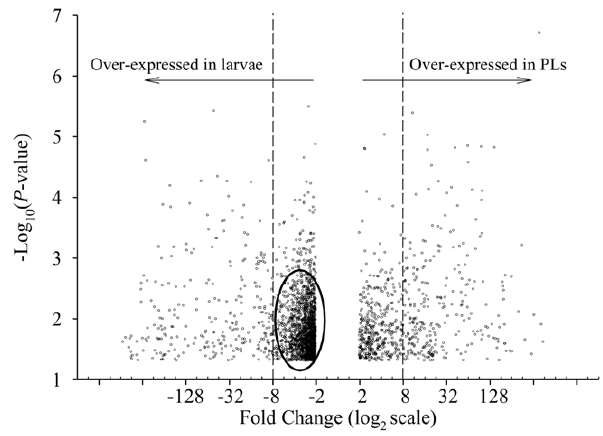
Figure 2. Volcano plot of transcript expression differences between larval and post-larval prawns. The magnitude of the difference in gene expression between larval and post-larval M. rosenbergii is shown on the X-axis on a log 2 scale (post-larval/larval) of intensity (with minimum 2-fold change). The significance of the difference is given as the -log 10 ( P -value) obtained from a t test (with a minimum P -value =0.05). The mass of transcripts that are slightly over- represented in larvae (2–8-fold) are circled. Dashed lines represent the border of 8-fold change in larvae (-8 and left) and post-larvae (8 and right).